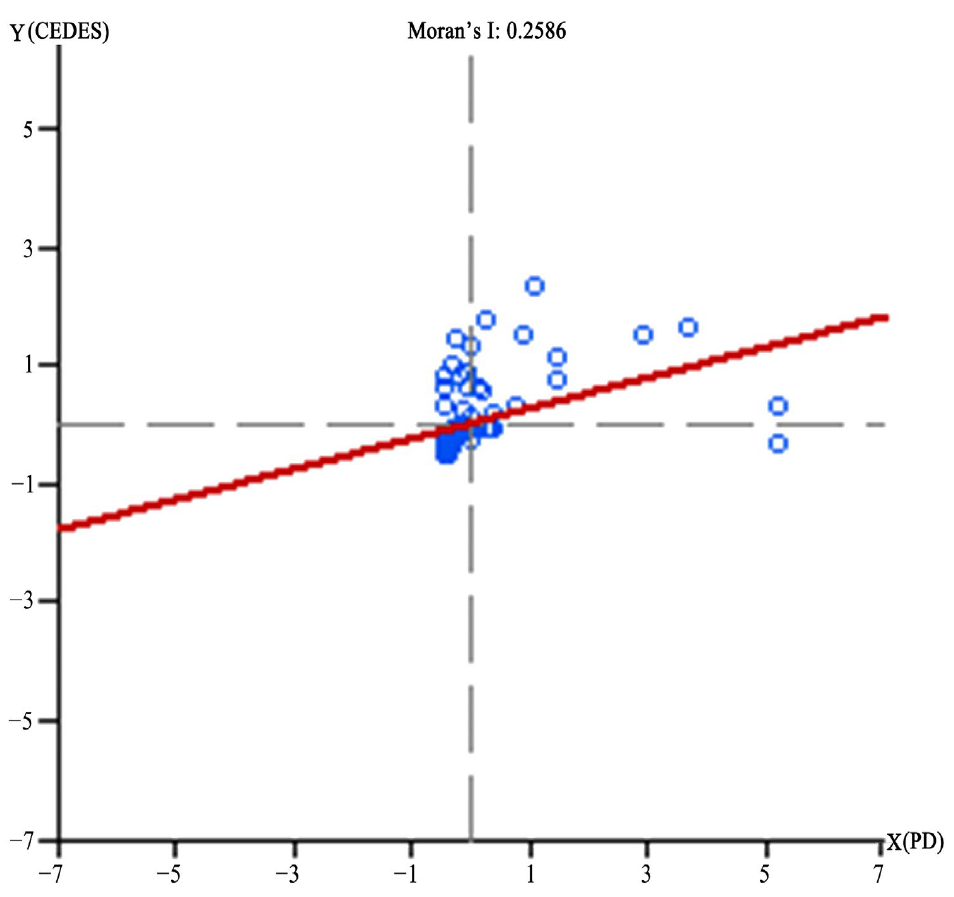
Figure 4. The Moran’s I scatter diagram of population density and comprehensive excessive demands for ESs.